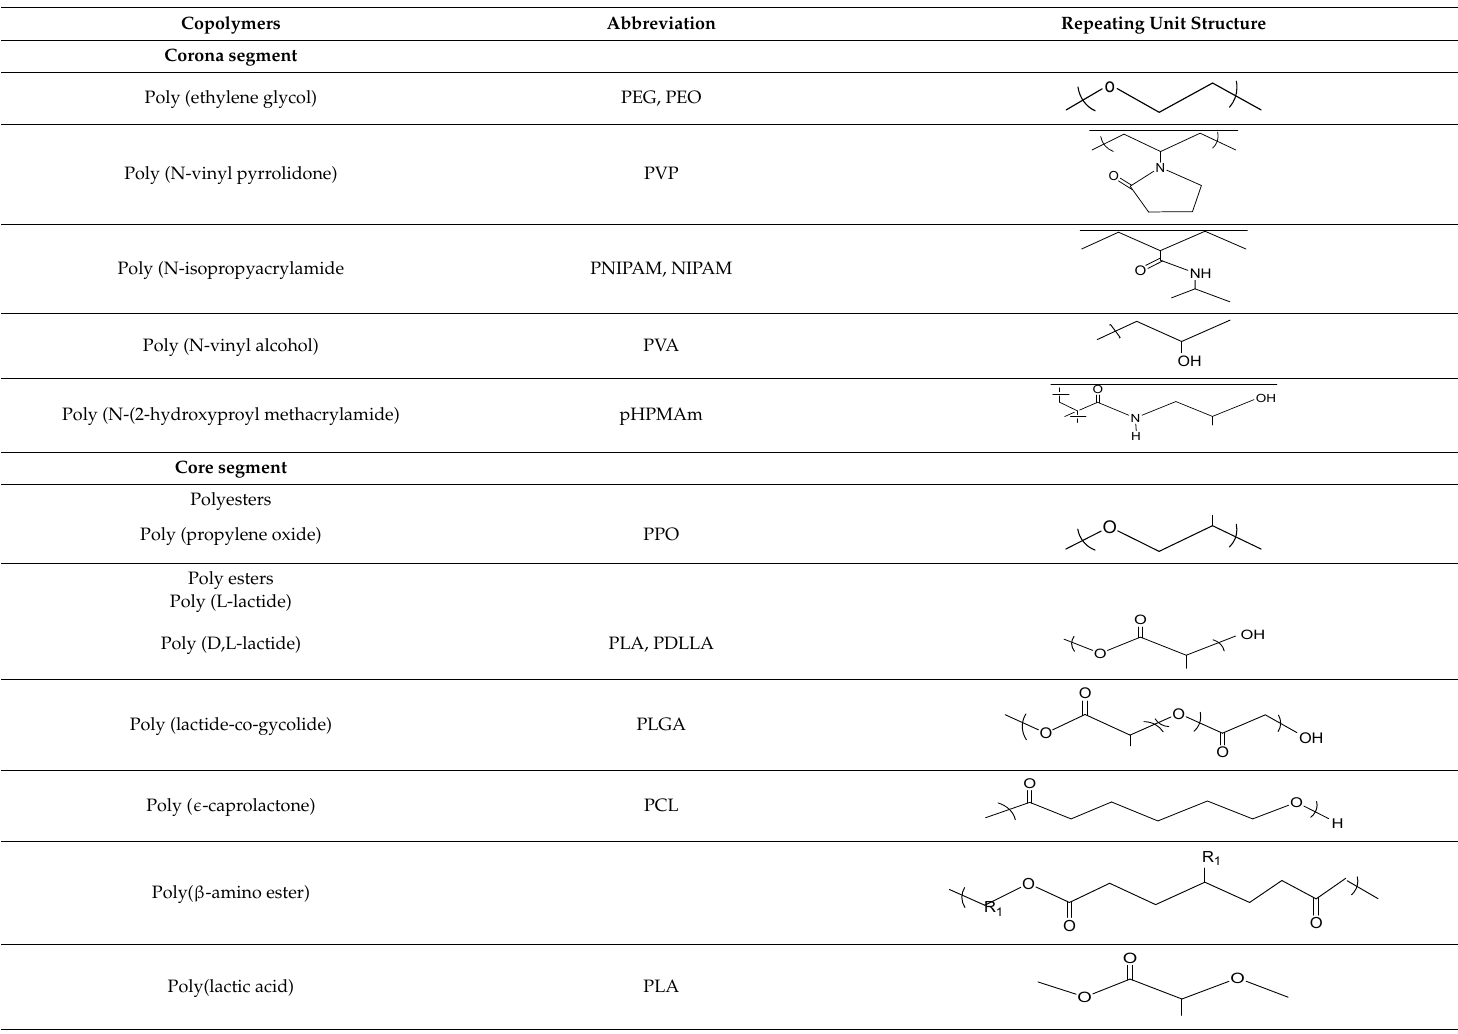
Table 2. Building block copolymers employed in micelle drug transport nanosystems (adapted from Sutton et al., 2007) [69].